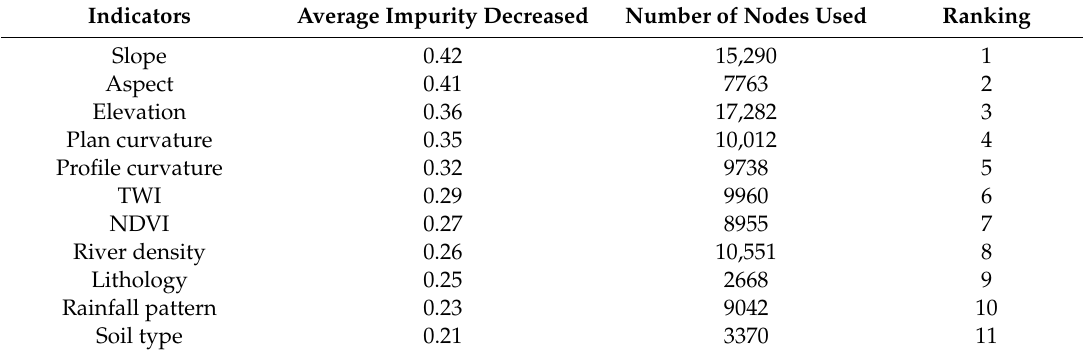
Table 2. The relative importance of flash flood indicators using the random forest model.